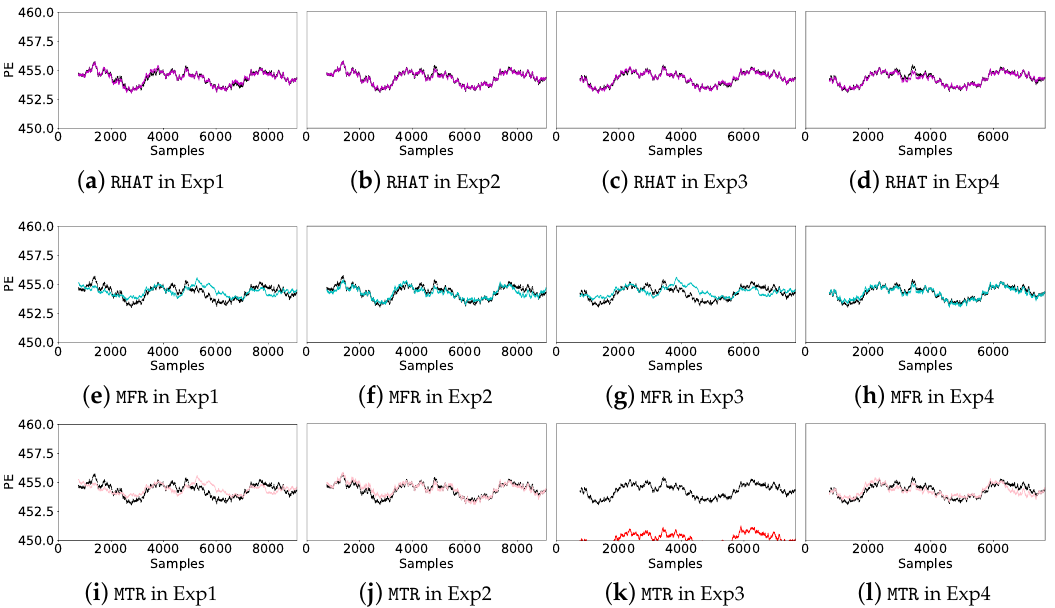
Figure 9. Real (black line) and predicted (colored line) PEs of RHAT , MFR and MTR for run 0. A moving average of 750 instances (1 month approx.) has been applied to smooth out short-term fluctuations.